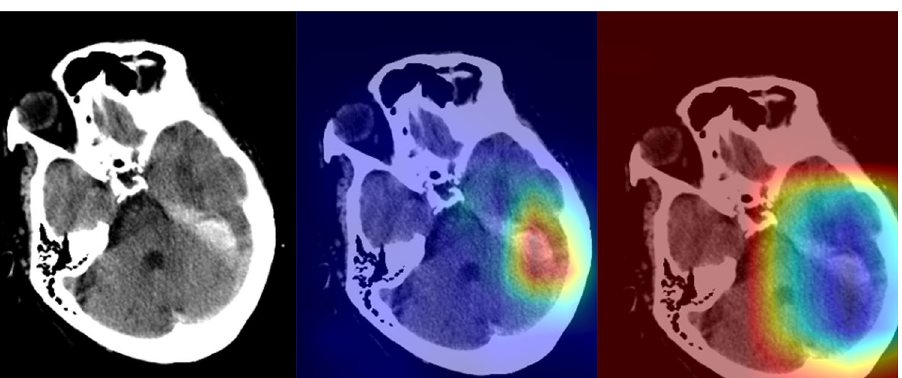
Figure 4. A 71-year-old man with a recent history of head trauma (The images were created by the authors using open-source software, Matplotlib v3.5, Python v3). Non-contrast head CT scan shows a subdural hematoma along the left tentorium cerebelli (right). NormGrad (middle) method generates finer saliency maps than Grad-CAM (left), highlighting the subdural hematoma. The average quality scores were 3.8 points and 1.8 points for the NormGrad and Grad-CAM, respectively. Please note that the observers evaluated saliency maps with the same color spectrum, and the current color maps are adjusted for representative